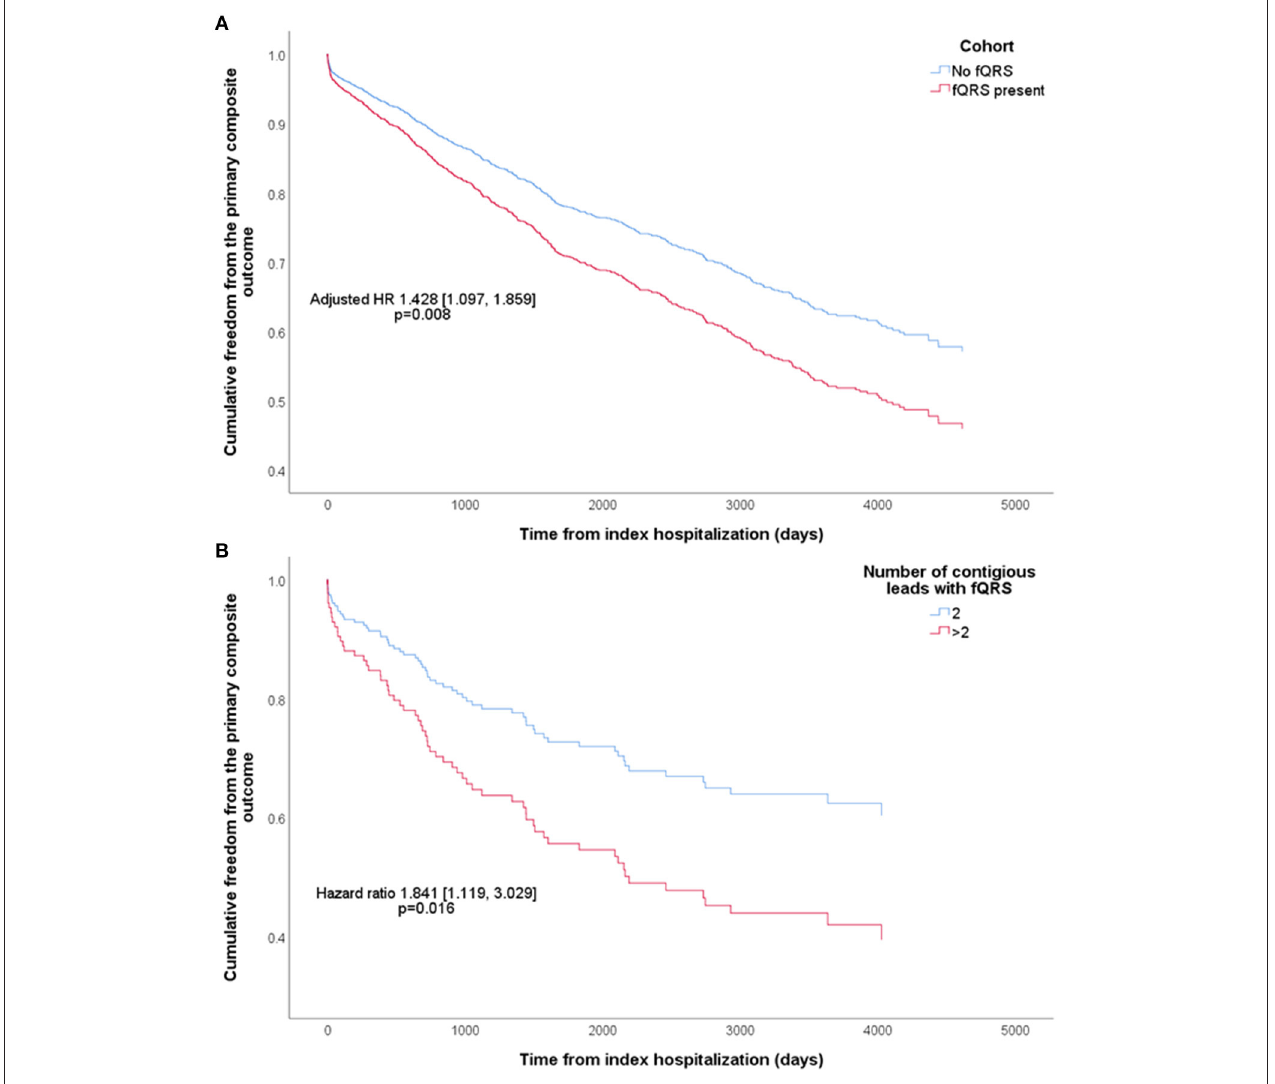
FIGURE 2 | Kaplan-Meier curves of cumulative freedom from the primary composite outcome of (A) all patients, stratified by the presence of fragmented QRS (fQRS), and (B) patients with fQRS, stratified by fQRS burden. The hazard ratio (HR) shown was adjusted for baseline characteristics that predicted the primary composite